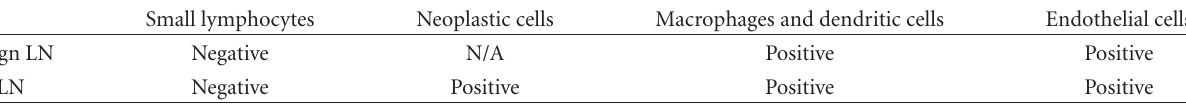
Table 1: Thymidine phosphorylase immunohistochemical stain (cytoplasmic/nuclear). Small